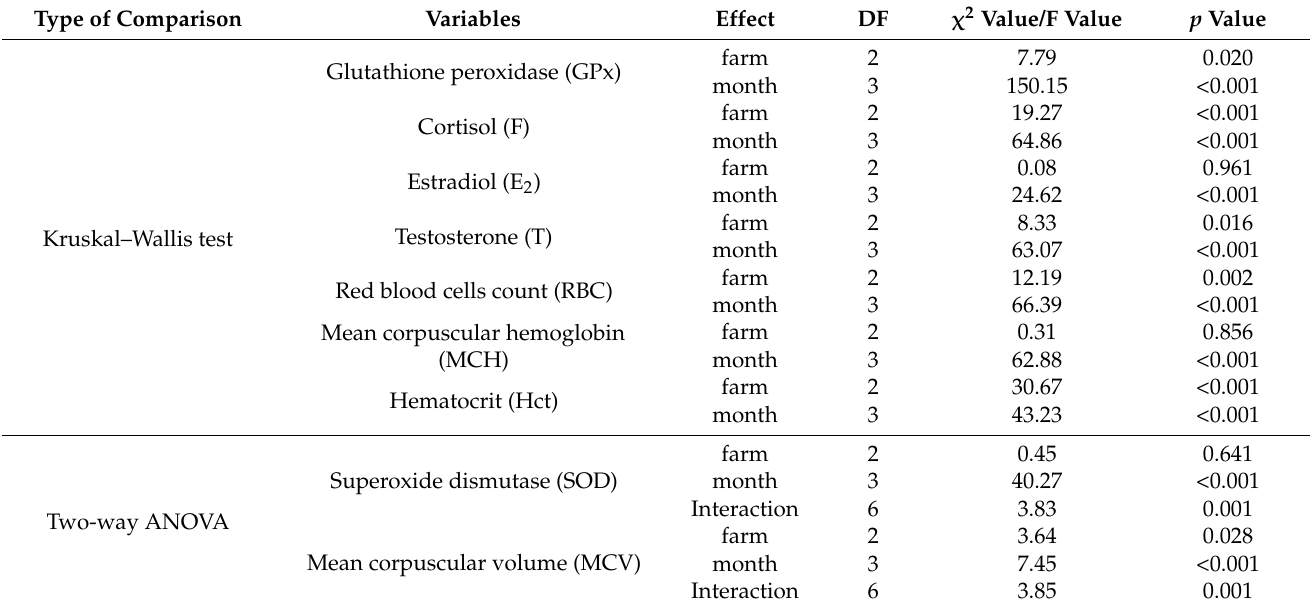
Table 3. Summary table of the ANOVA/Kruskal–Wallis tests performed on physiological, hormonal, and hematological variables recorded over four months (May–August 2019) in three fish farms from